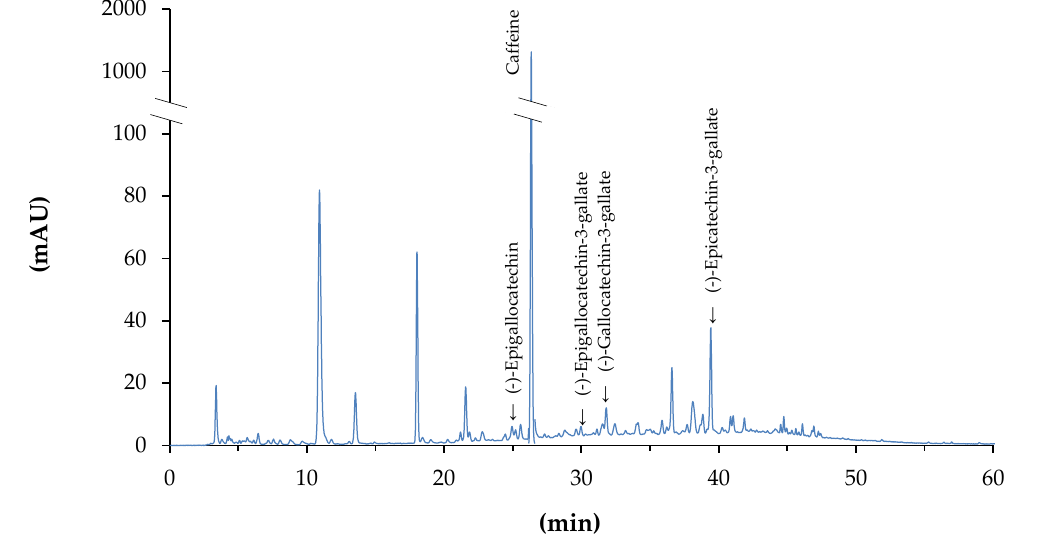
Figure 1. High performance liquid chromatography (HPLC) chromatogram of the tea sample.